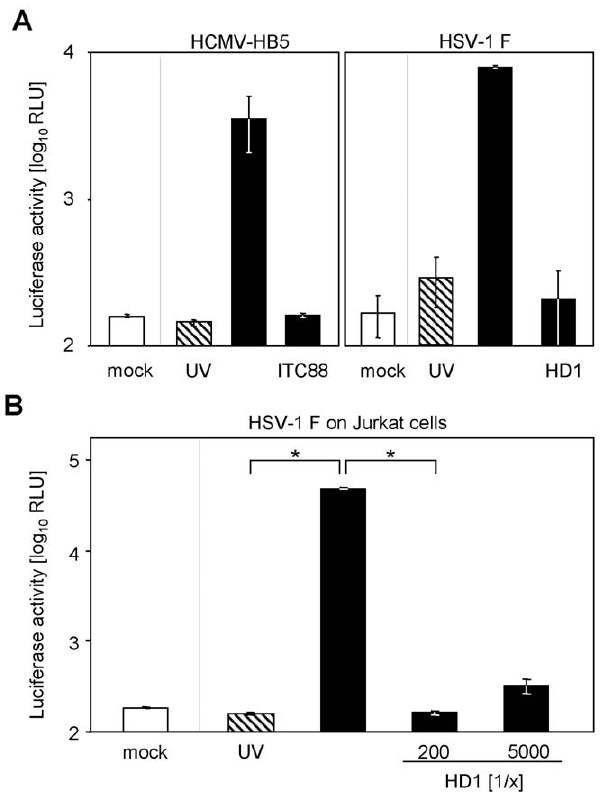
Figure 10. Viral transactivation can be neutralized by monoclo- nal antibodies in MRC-5 and Jurkat cells. ( A ) MRC-5 cells were transiently transfected (Lipofectamine 2000 CD) with the pTA-Control plasmid. Cells were infected with HCMV-HB5 (left panel) or HSV-1 strain F (right panel). Replication competent virus (black bars) was compared with UV-inactivated virus (hatched bars). HCMV was incubated for 1 h at 37 u C before infection with 25 m g/ml of the HCMV gB-specific monoclonal antibody ITC88 and HSV-1 with the HSV-1 gD-specific monoclonal antibody HD1 before infection. Cells were lysed and luciferase activity was determined. ( B ) Jurkat cells were transfected with pTA-Control plasmid using the Lonza transfection reagents and protocol. Cells were infected with UV-inactivated HSV-1 strain F (hatched bar), replication competent HSV-1 (black bars) or left uninfected (white bar). Virus was incubated before infection for 1 h at 37 u C with indicated dilutions of HSV gD monoclonal antibody HD1. , 20 h p. i. cells were lysed and the expressed luciferase activity was